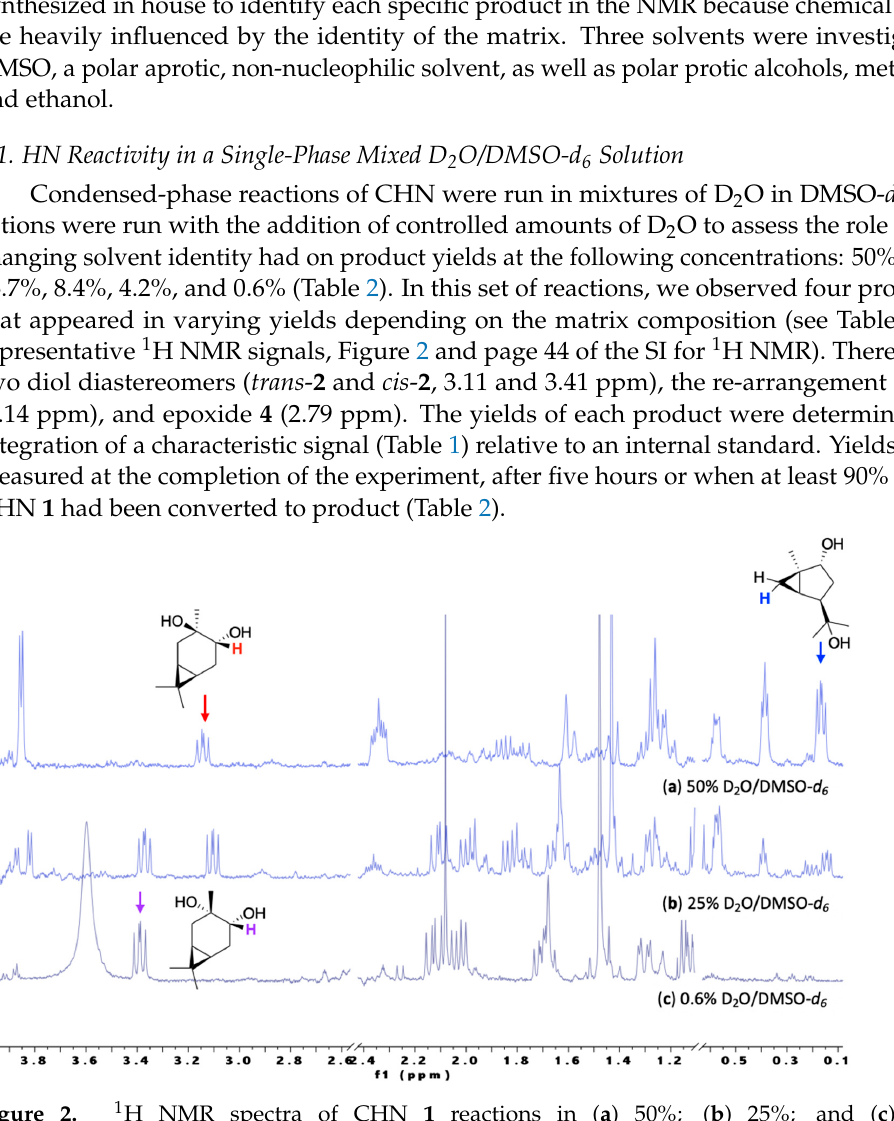
Figure 2. 1 H NMR spectra of CHN 1 reactions in ( a ) 50%; ( b ) 25%; and ( c ) 0.6% D 2 O/DMSO- d 6 mix-